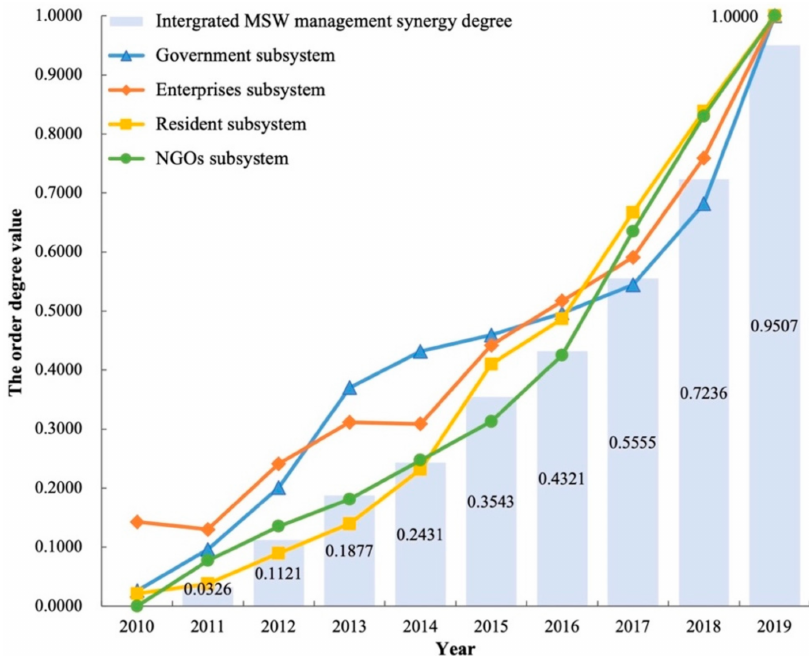
Figure 3. Development trend of the synergy